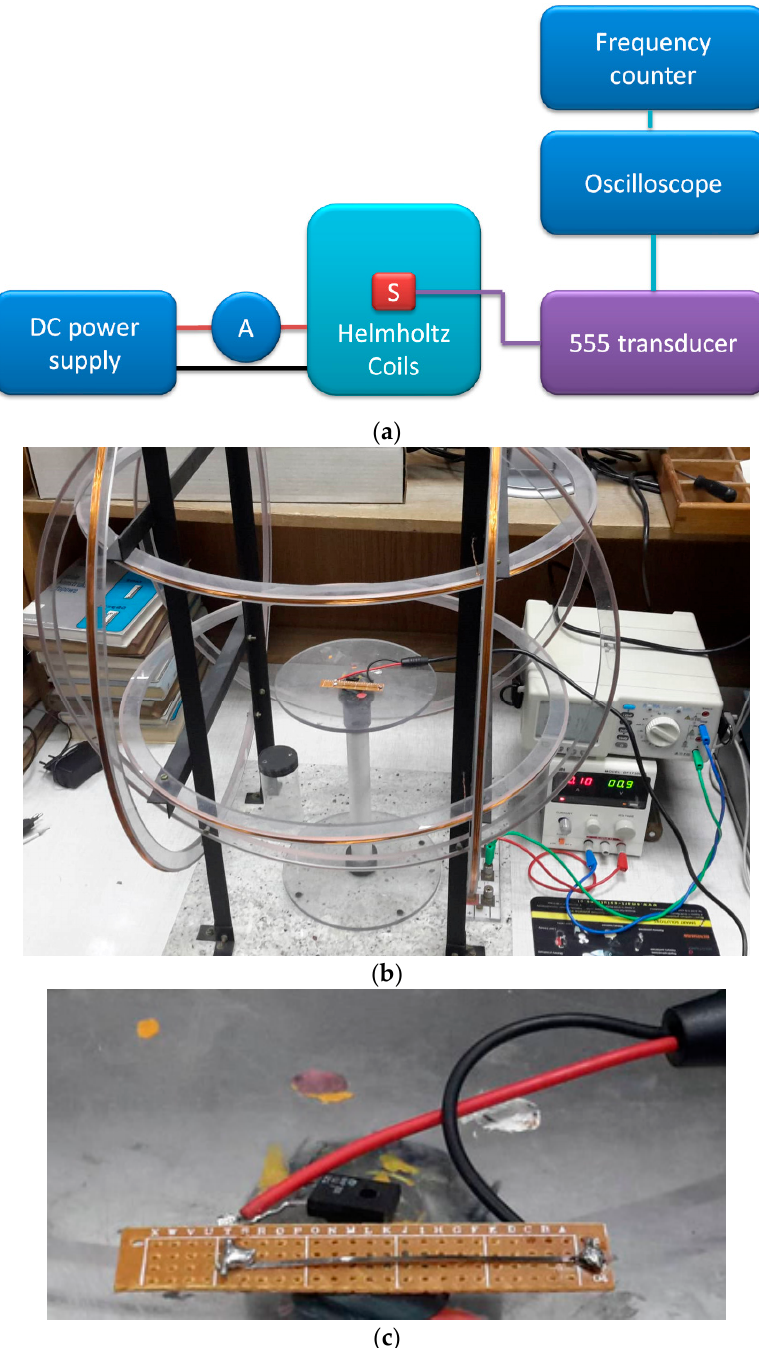
Figure 6. ( a ) Schematic diagram of measurement test stand for GMI magnetic field sensor calibration; ( b ) photo of actual test stand; ( c ) details of developed sensor.